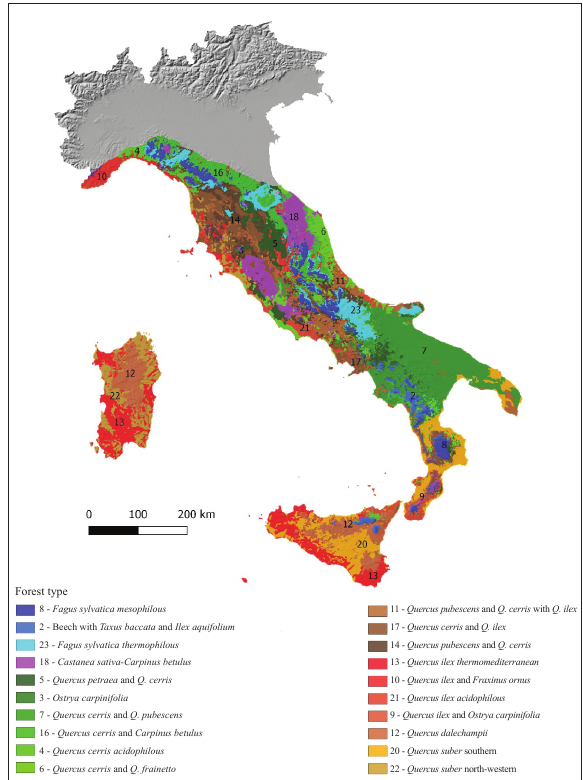
Figure 2. Map of the predictive distribution of the 20 groups based on the discriminant functions applied to environmental factors. The grey color indicates the part of the Italian peninsula not included in the analysis (Alps and the Po Plain).